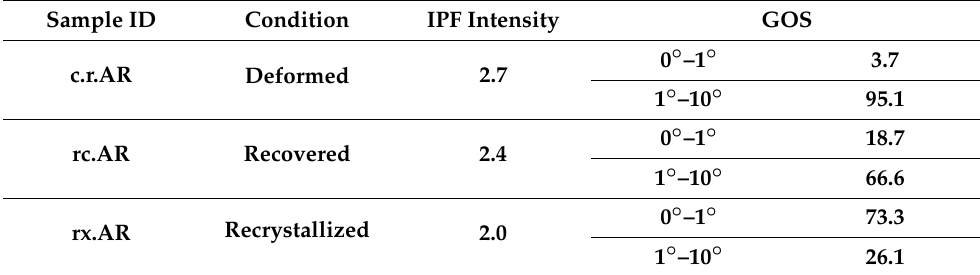
Table 3. Results of misorientation angles, IPF intensities, and GOS